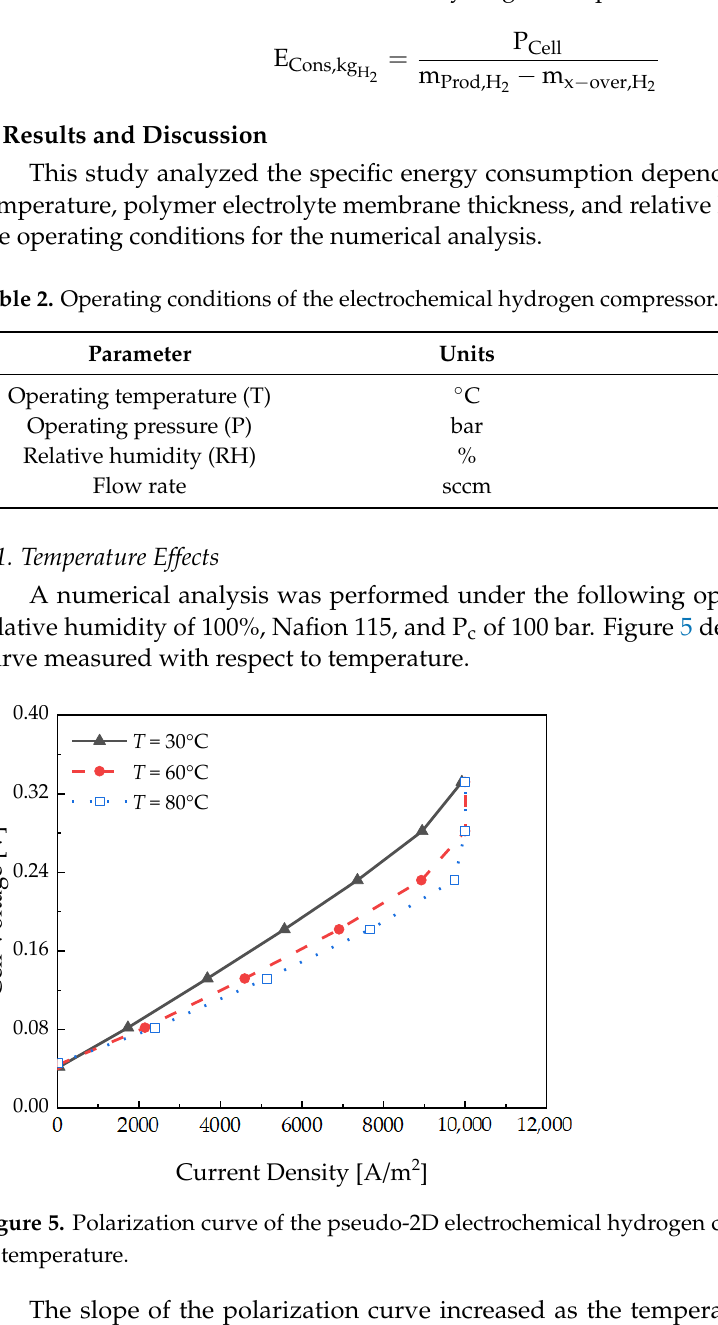
Table 2. Operating conditions of the electrochemical hydrogen compressor.